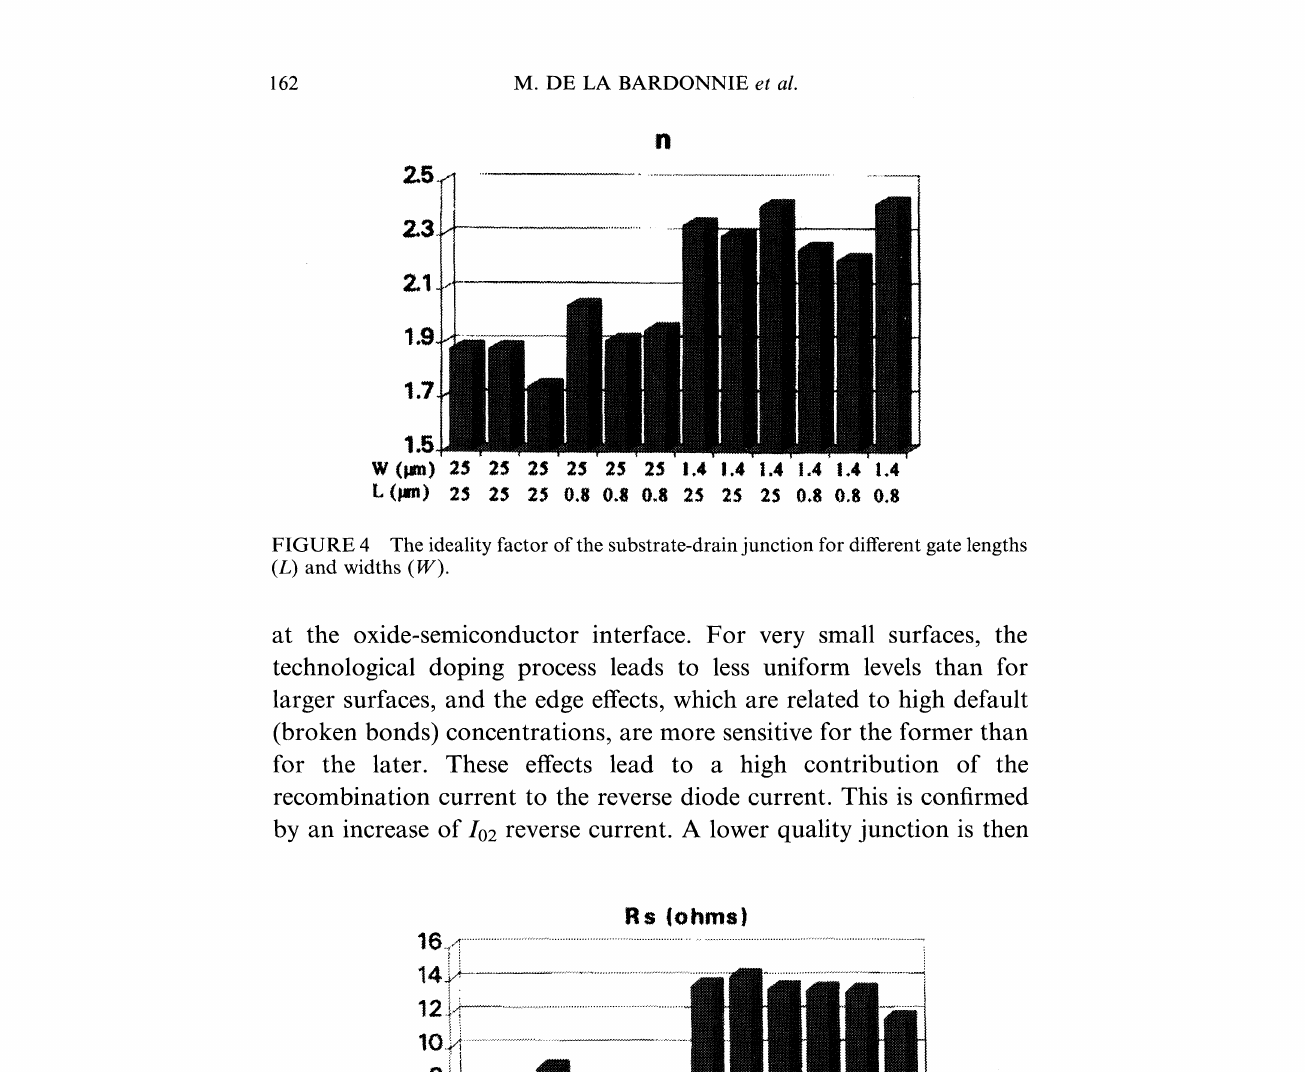
FIGURE 5 The series resistance of the substrate-drain junction for different gate lengths (L) and widths